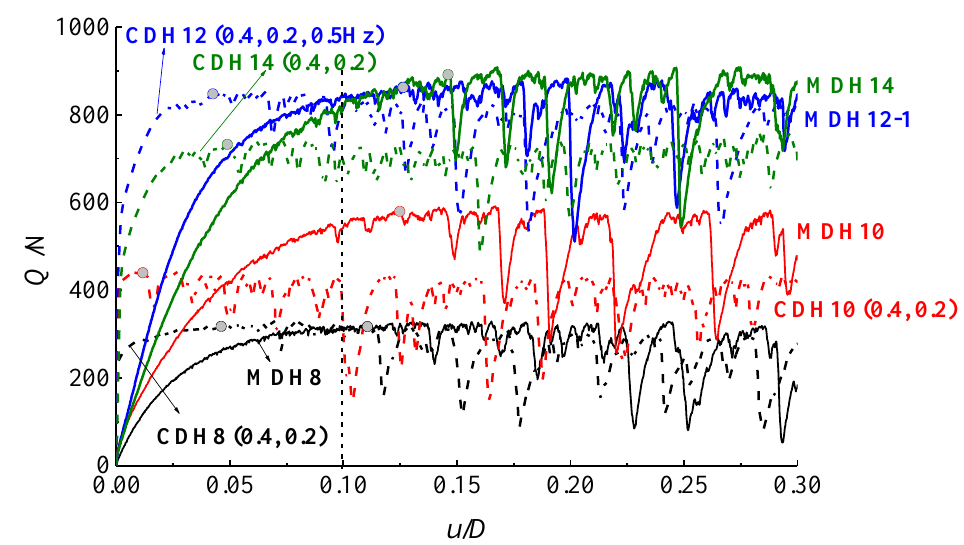
Figure 9. Post-cyclic monotonic and monotonic responses for different embedment ratios.